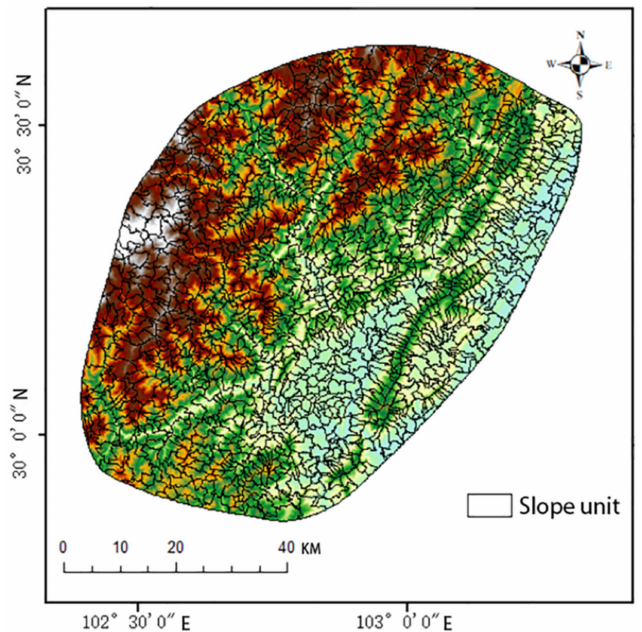
Figure 3. Result of slope unit division in the study